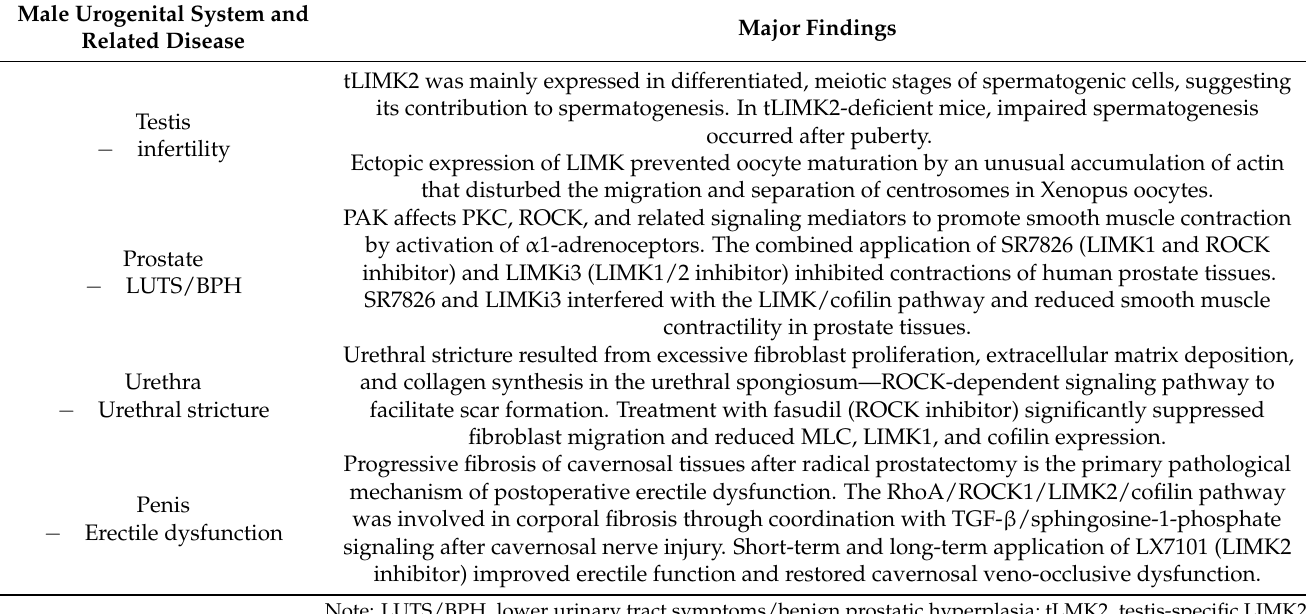
Table 1. Summary of major findings of LIM kinase in the male urogenital